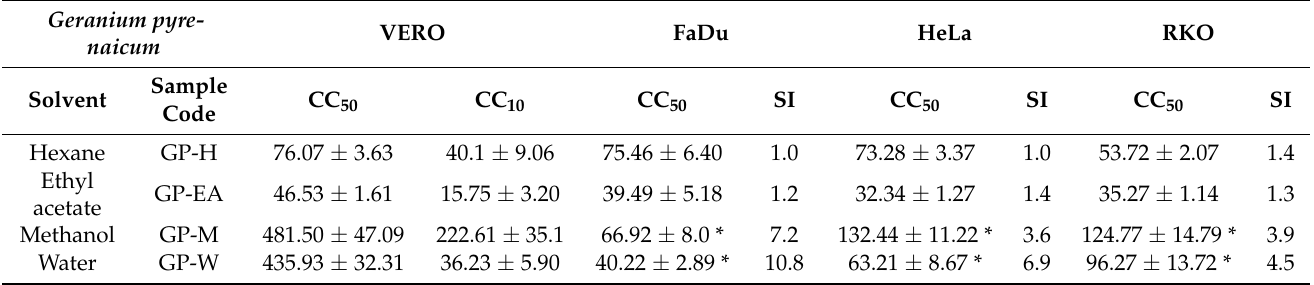
Table 5. Cytotoxicity of Geranium pyrenaicum extracts.